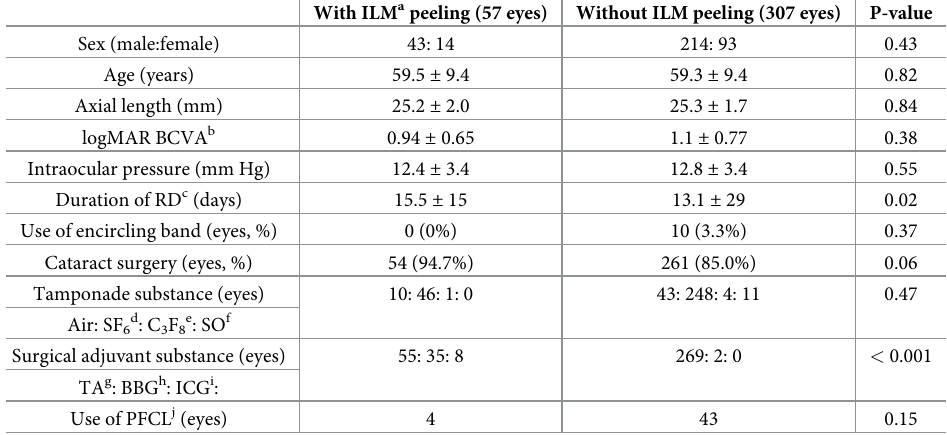
Table 2. Baseline characteristics and surgical details for the eyes with a macula-off rhegmatogenous retinal detachment. With ILM a peeling (57 eyes) Without ILM peeling (307 eyes) P-value Sex (male:female) 0.43